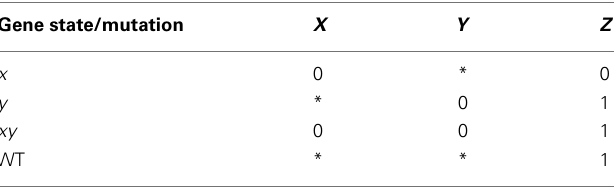
Table 5 | Results obtained through epistasis analysis of the theoretical example described in the main